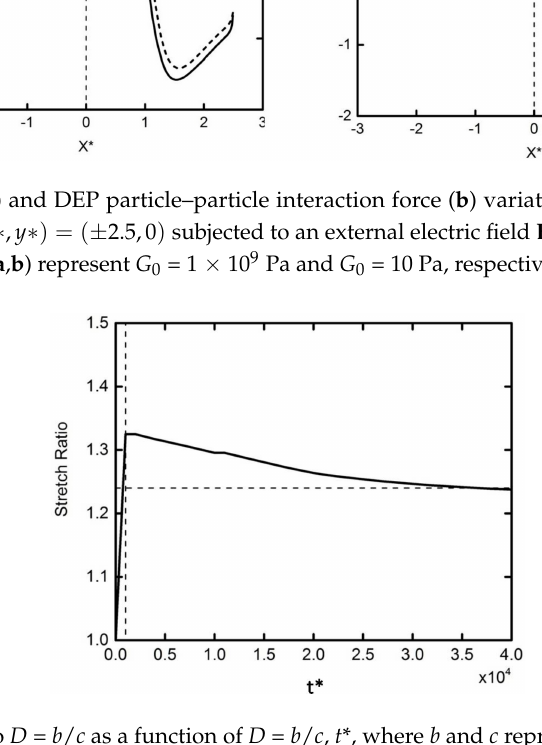
Figure 5. Stretch ratio D = b / c as a function of D = b / c , t *, where b and c represent the semimajor axis and the semiminor axis of the deformable ellipse, G 0 = 10